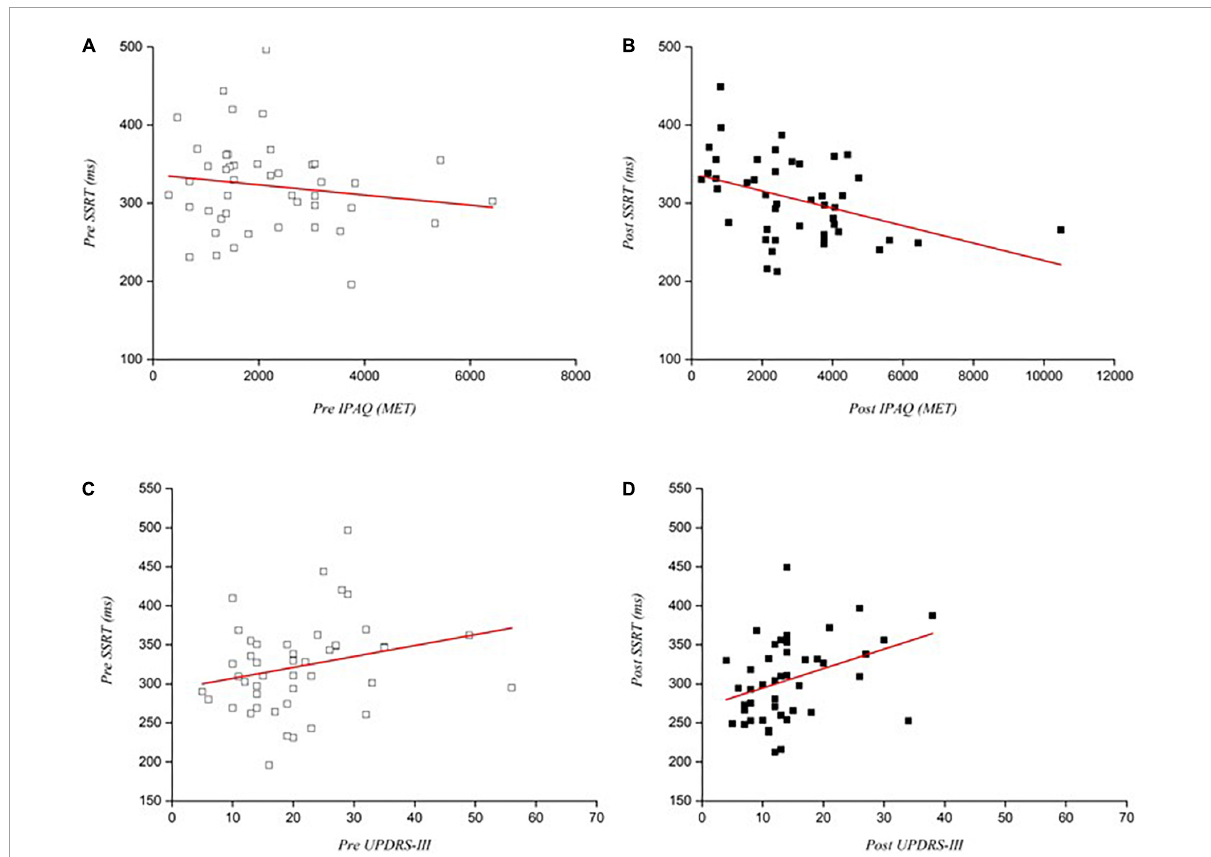
FIGURE5 Correlations between physical activity levels and motor performance with SSRTs pre and post intervention. (A) Correlation between SSRTs with physical activity pre-intervention ( p = 0.322); (B) Correlation between SSRTs with physical activity post-intervention ( p = 0.006); (C) Correlation between SSRTs with UPDRS-III scores pre-intervention ( p = 0.099); (D) Correlation between SSRTs with UPDRS-III scores post-intervention ( p = 0.016). SSRT, Stop signal reaction